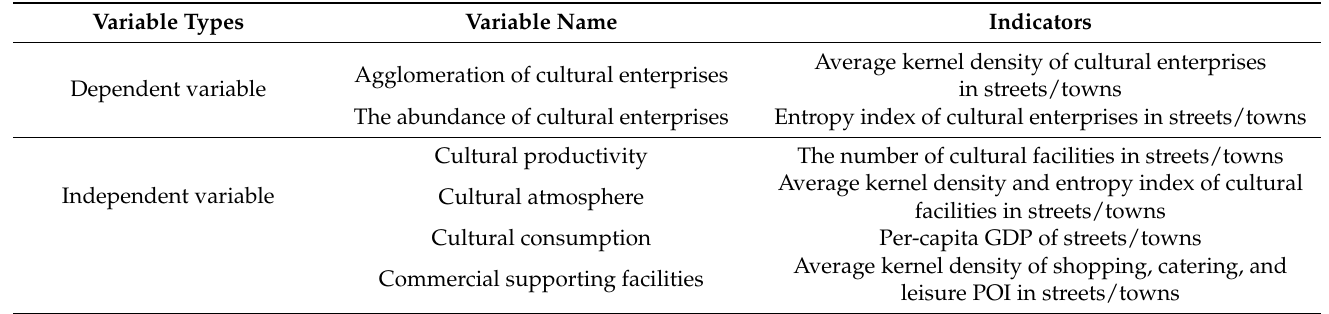
Table 1. Variable definitions of the